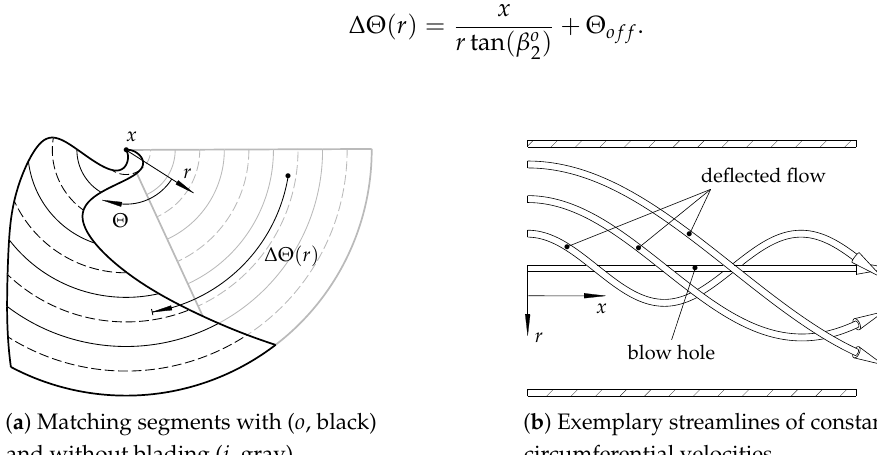
and the axial distance x 2